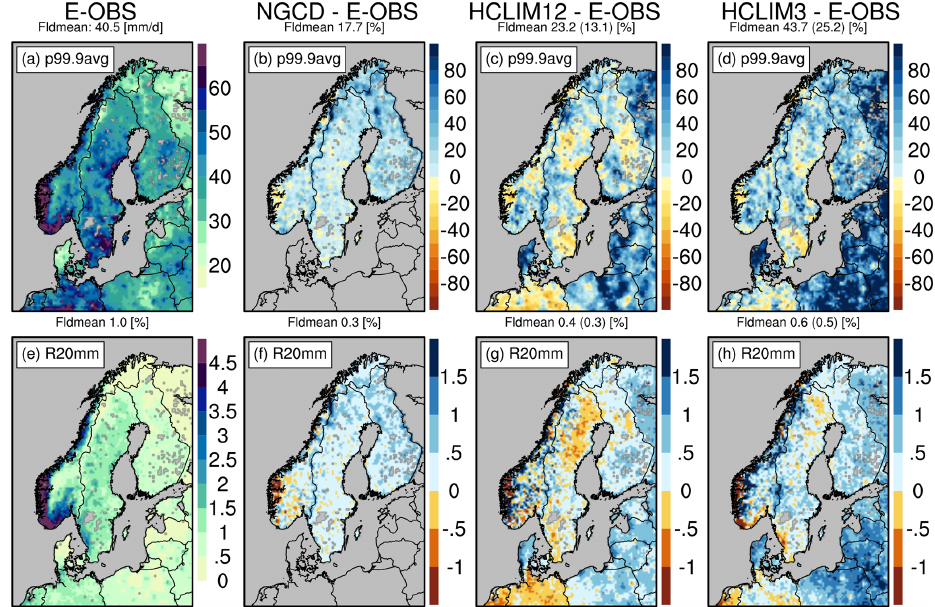
Figure 2. (a–d) Average daily precipitation above the 99.9th percentile (p99 . 9 avg ) in (a) E-OBS and the relative biases of p99 . 9 avg values in (b) NGCD, (c) HCLIM12, and (d) HCLIM3 with a reference to E-OBS. (e–h) R20mm values in (e) E-OBS and the percentage points (model–observations) of R20mm values in (f) NGCD, (g) HCLIM12, and (h) HCLIM3 with a reference to E-OBS. The NGCD and HCLIM data were remapped onto E-OBS’s grid prior to the analysis. Fldmean represents the average bias over the domain, and the values in brackets show the average bias over the NGCD domain. All units are in percentage except in (a) , where the unit is millimeters per day.